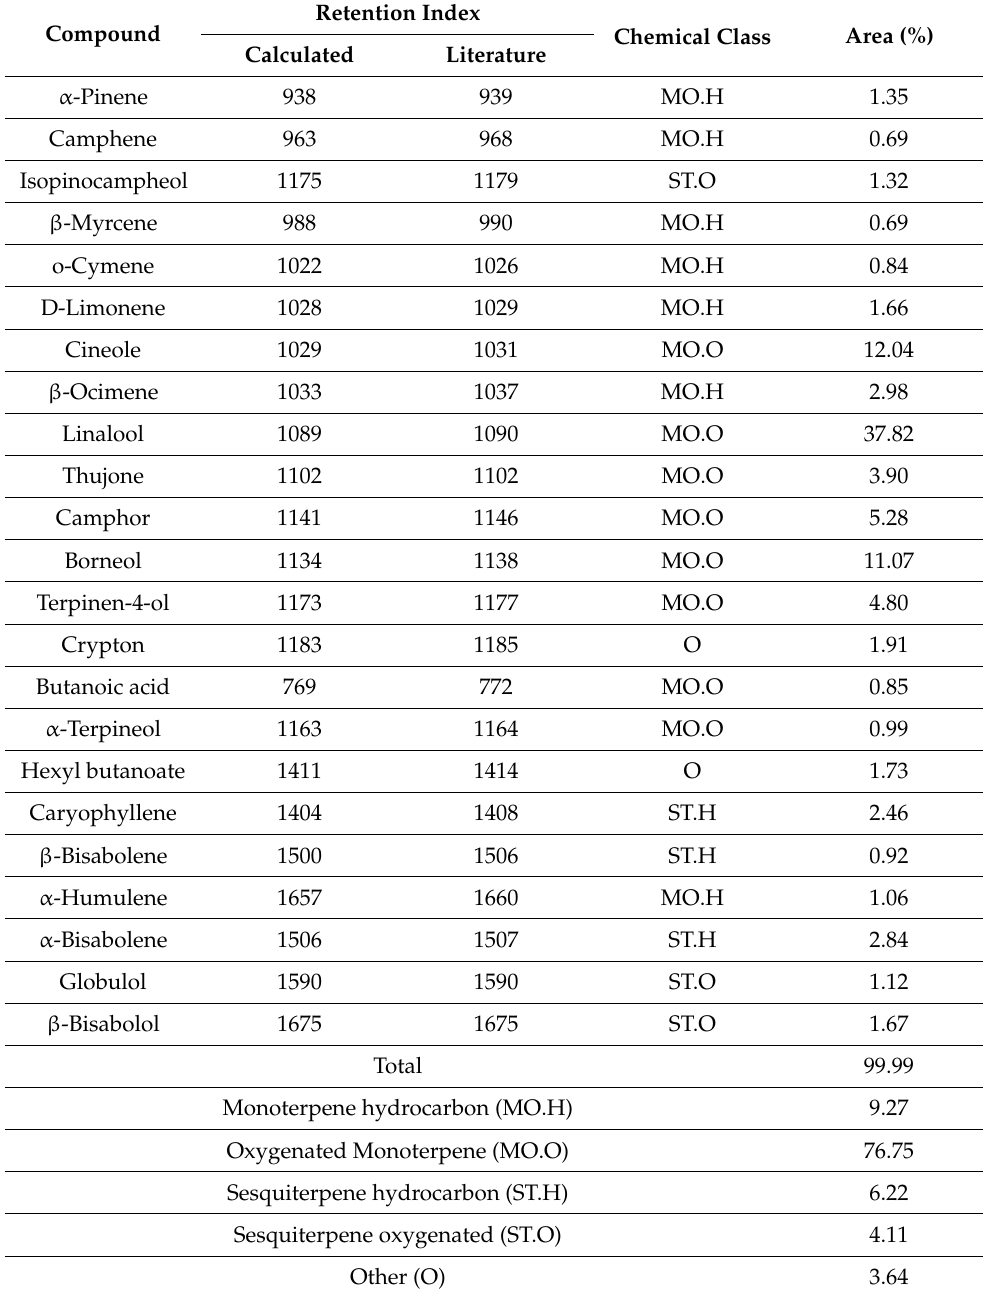
Table 1. Phytochemical compounds identified in EOBD by